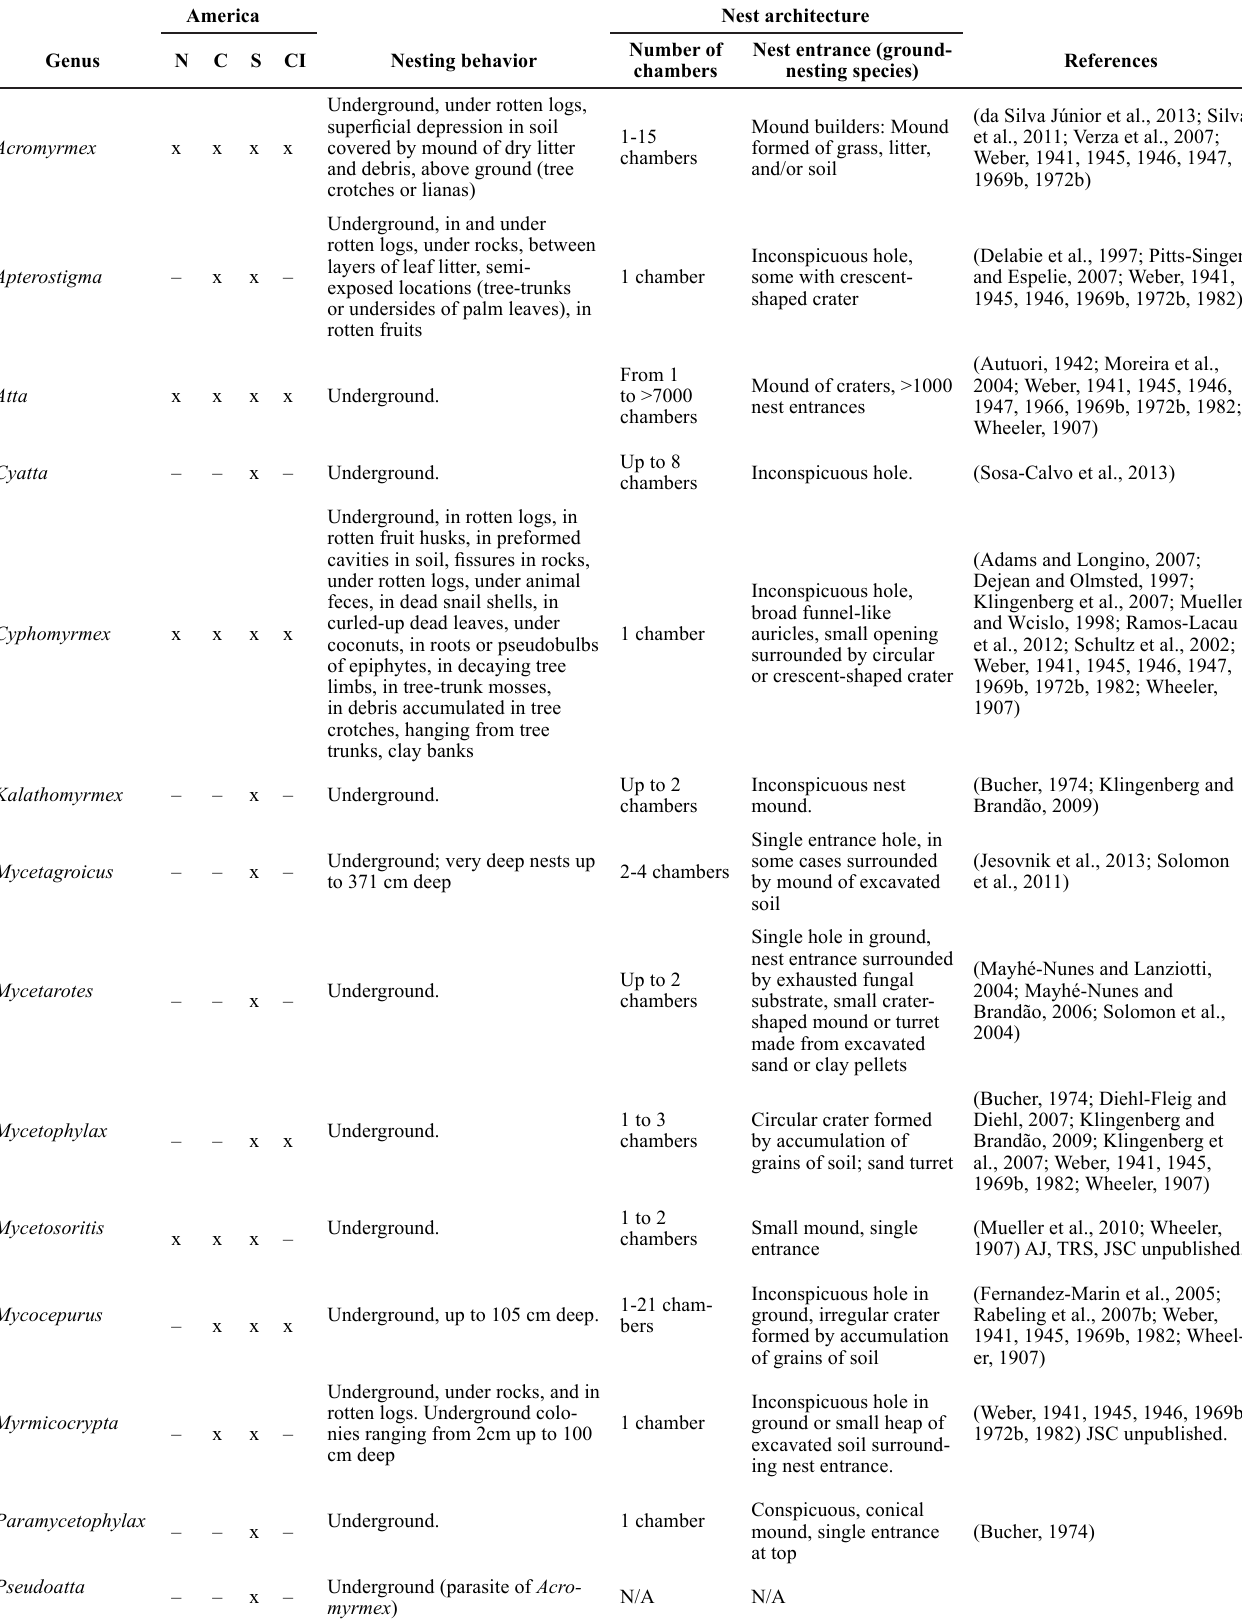
Table 1. Known distribution of the fungus-farming ant genera with information of nesting behavior and nesting